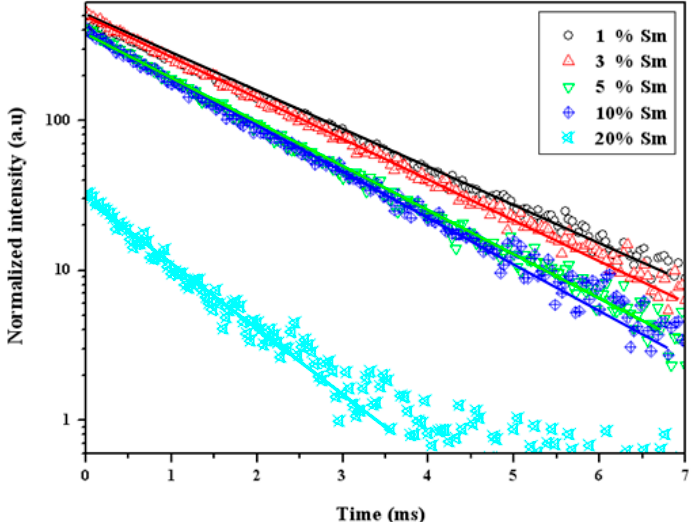
Figure 6. Decay curves for the 4 G 5/2 → 6 H 7/2 transition of YInGe 2 O 7 doped with different Sm 3+ ion concentrations under an excitation of 404 nm.